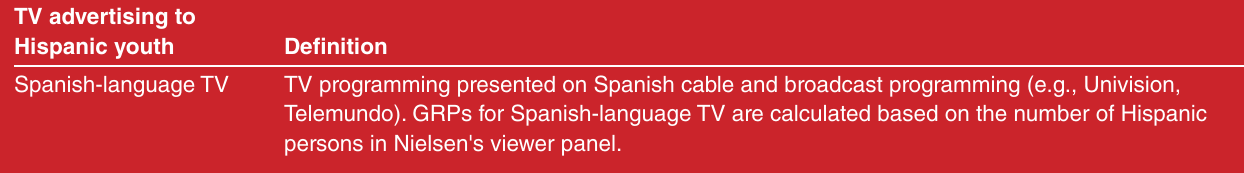
Table 38 provides Spanish-language TV advertising spending